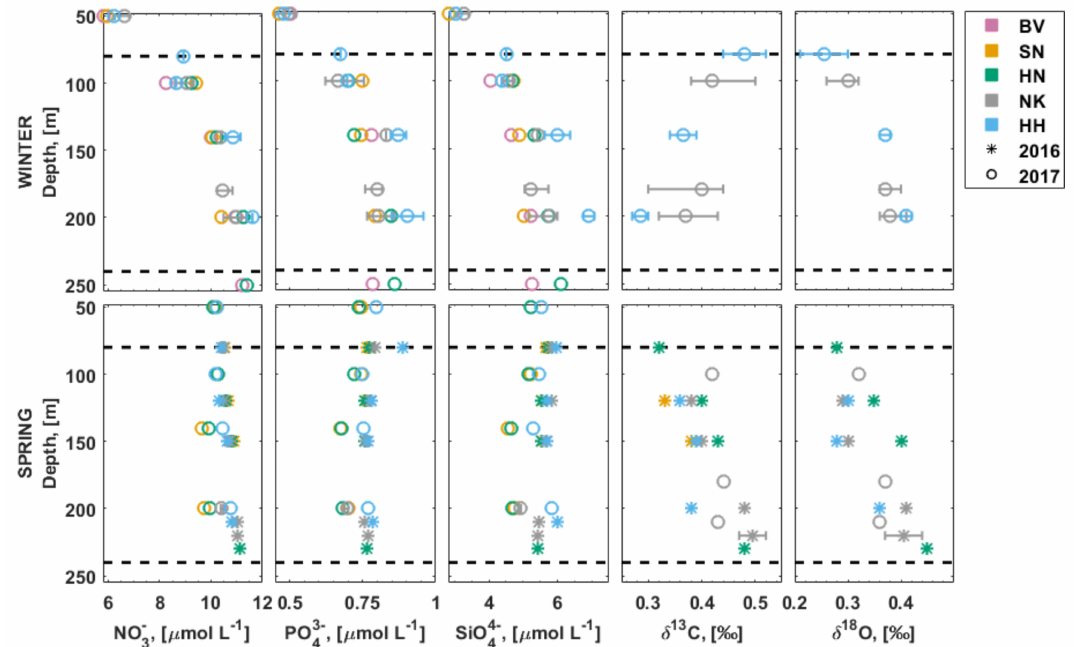
Figure 7. Depth profiles (y-axes) of biogeochemical water properties at depths 50–250 m of the Langenuen Fjord: (first row) January 2017, (second row) April 2017 and May 2016, for (first column) nitrate, NO 3 − , (second column) phosphate, PO 43 − , (third column) silicate, SiO 44 − , (fourth column) carbon isotope, δ 13 C, (fifth column) oxygen isotope, δ 18 O. The errorbars show the range of the variable (min, max) for cruises with multiple CTD cast samples from one site, and the marker shows the median for the site (HH—blue, NK—gray, HN—green, SN—orange, BV—purple) over the cruises. The 2016 measured values are shown with asterisks (*) and 2017 with circles (o). The dashed horizontal lines represent the definition for depths of the living CWCs (80–240